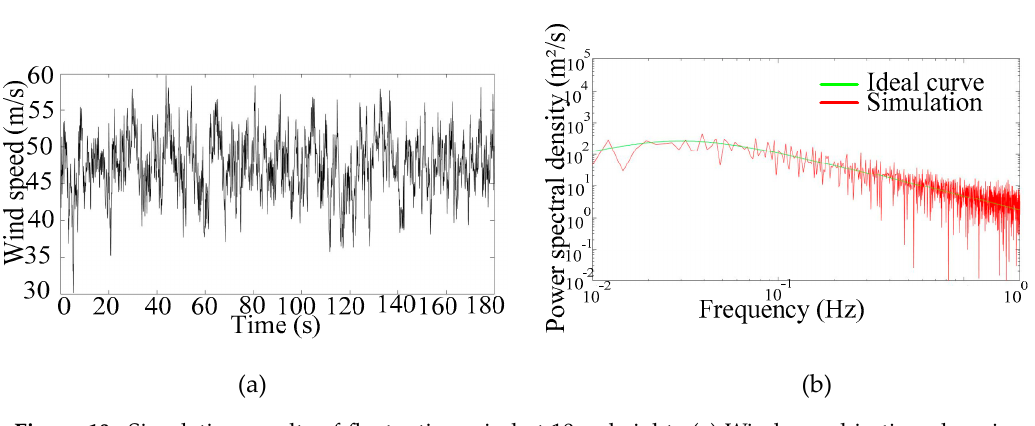
Figure 10. Simulation results of fluctuating wind at 10 m height. ( a ) Wind speed in time domain. ( b ) Power spectral density.